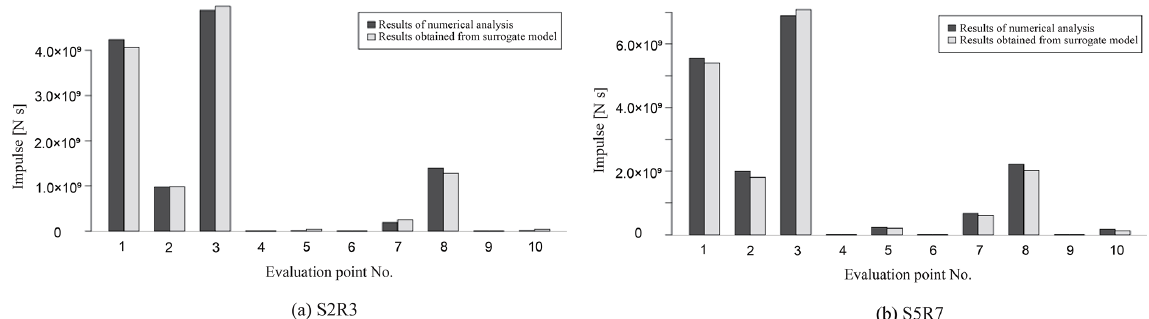
Figure 21. Comparison of impulses calculated from the results of numerical analysis and those obtained from the surrogate models (a , S2R3; b , S5R7 )